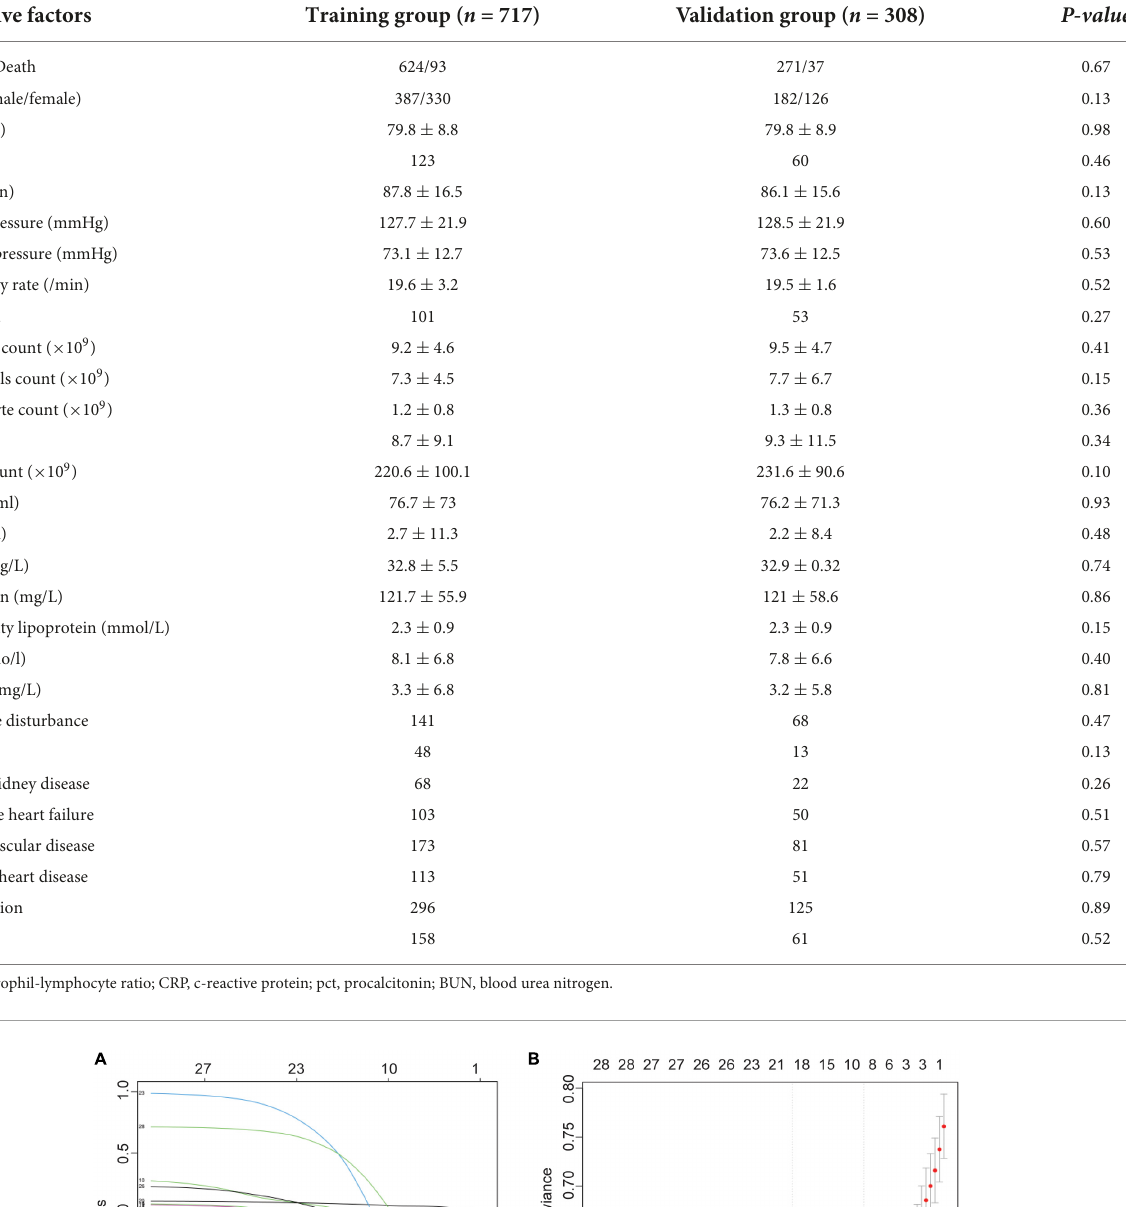
TABLE 2 Characteristics of the training and validation group.